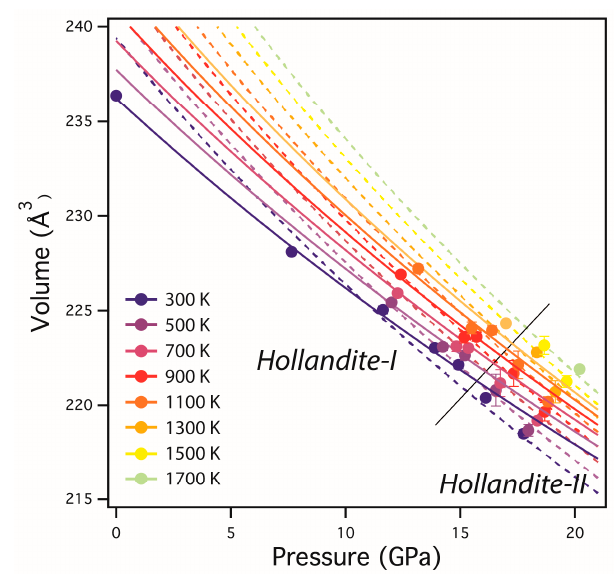
Figure 4. Unit-cell volume of K 0.7 Na 0.3 AlSi 3 O 8 liebermannite as a function of pressure and temperature. The color-scale represents the data at temperatures varying from 300 K to 1700 K, respectively. Pressure and volume error bars are within the size of the symbols. Solid and broken lines represent the isothermal compression curves obtained from fitting all the data to a Birch–Murnaghan EoS (Equations (1)–(5)) for the hollandite-I (plain lines) and hollandite-II (broken lines) phases, respectively.